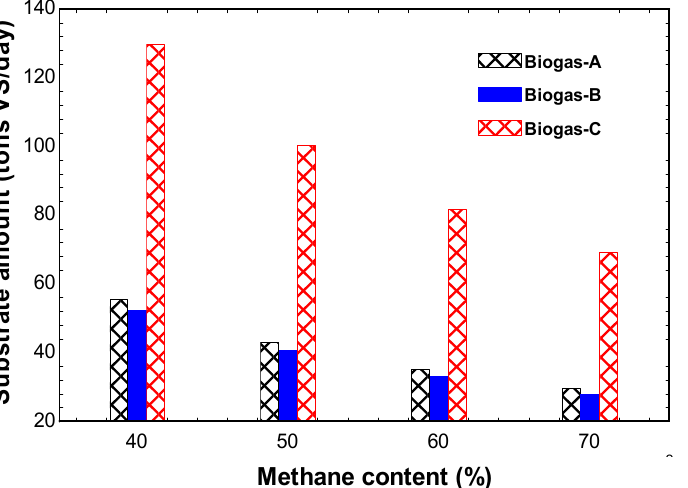
sense that the substrate amount required to produce the biogas in the biodigester will also vary for each biogas type. The effect of the biogas methane content on the substrate amount is shown in Figure 5 where the substrate amounts at 40% methane content are 55.58, 52.46, and 129.7 tons-VS/day for biogas A-C respectively. At 70% methane content, the substrate amounts for each biogas type reduces to 29.61, 27.95, and 69.12 tons-VS/day for biogas A-C respectively. This shows that the methane content of the biogas is a huge factor when designing a biogas-powered system.